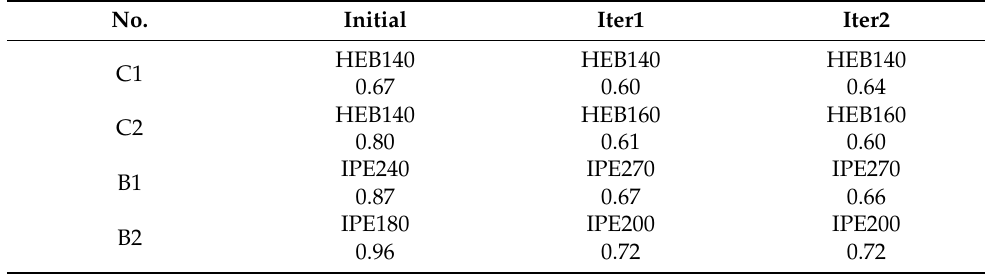
Table 3. Members and their most unfavorable ratio of demand to capacity in each iteration.